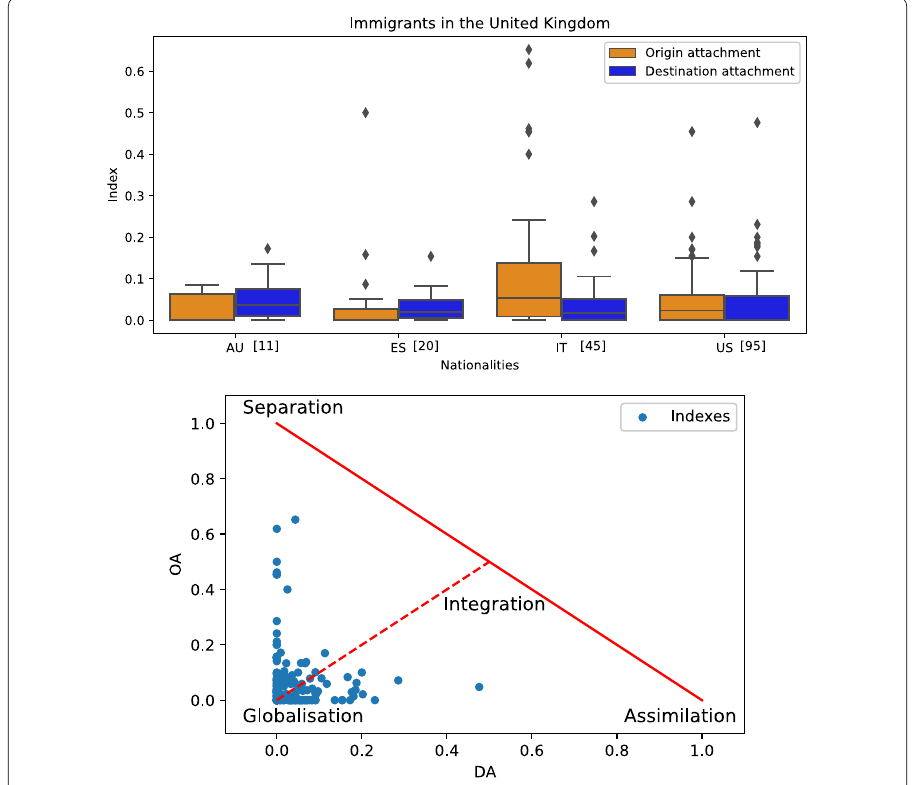
Figure 8 Top: Box plots for DA and OA for immigrants residing in the United Kingdom. Bottom: Scatter plot of OA vs. DA indicating approximate integration types for immigrants in the